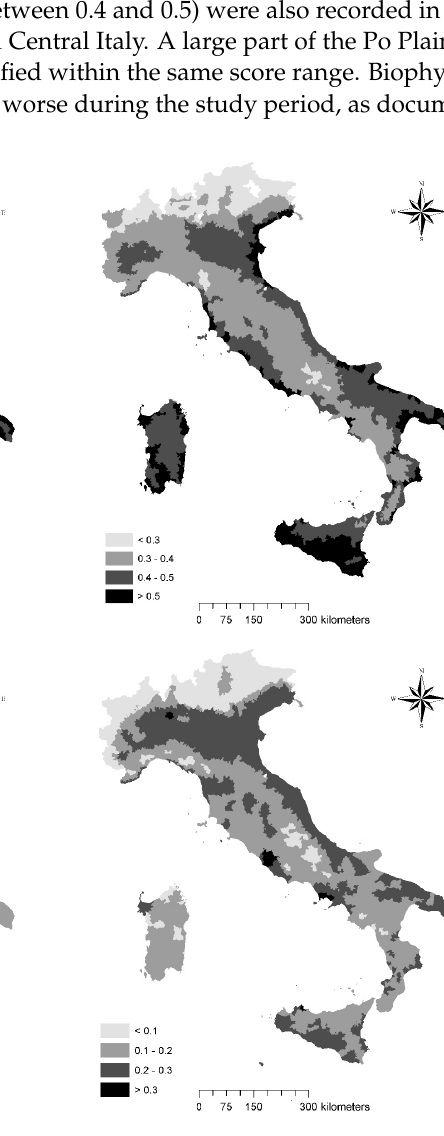
Figure 1. Spatial distribution of biophysical and socioeconomic components of soil sensitivity to degradation ( upper left , biophysical indicator in the Early-1990s; upper right : Early-2010s; lower left : Socioeconomic indicator in the Early-1990s; and lower right : Early-2010s).